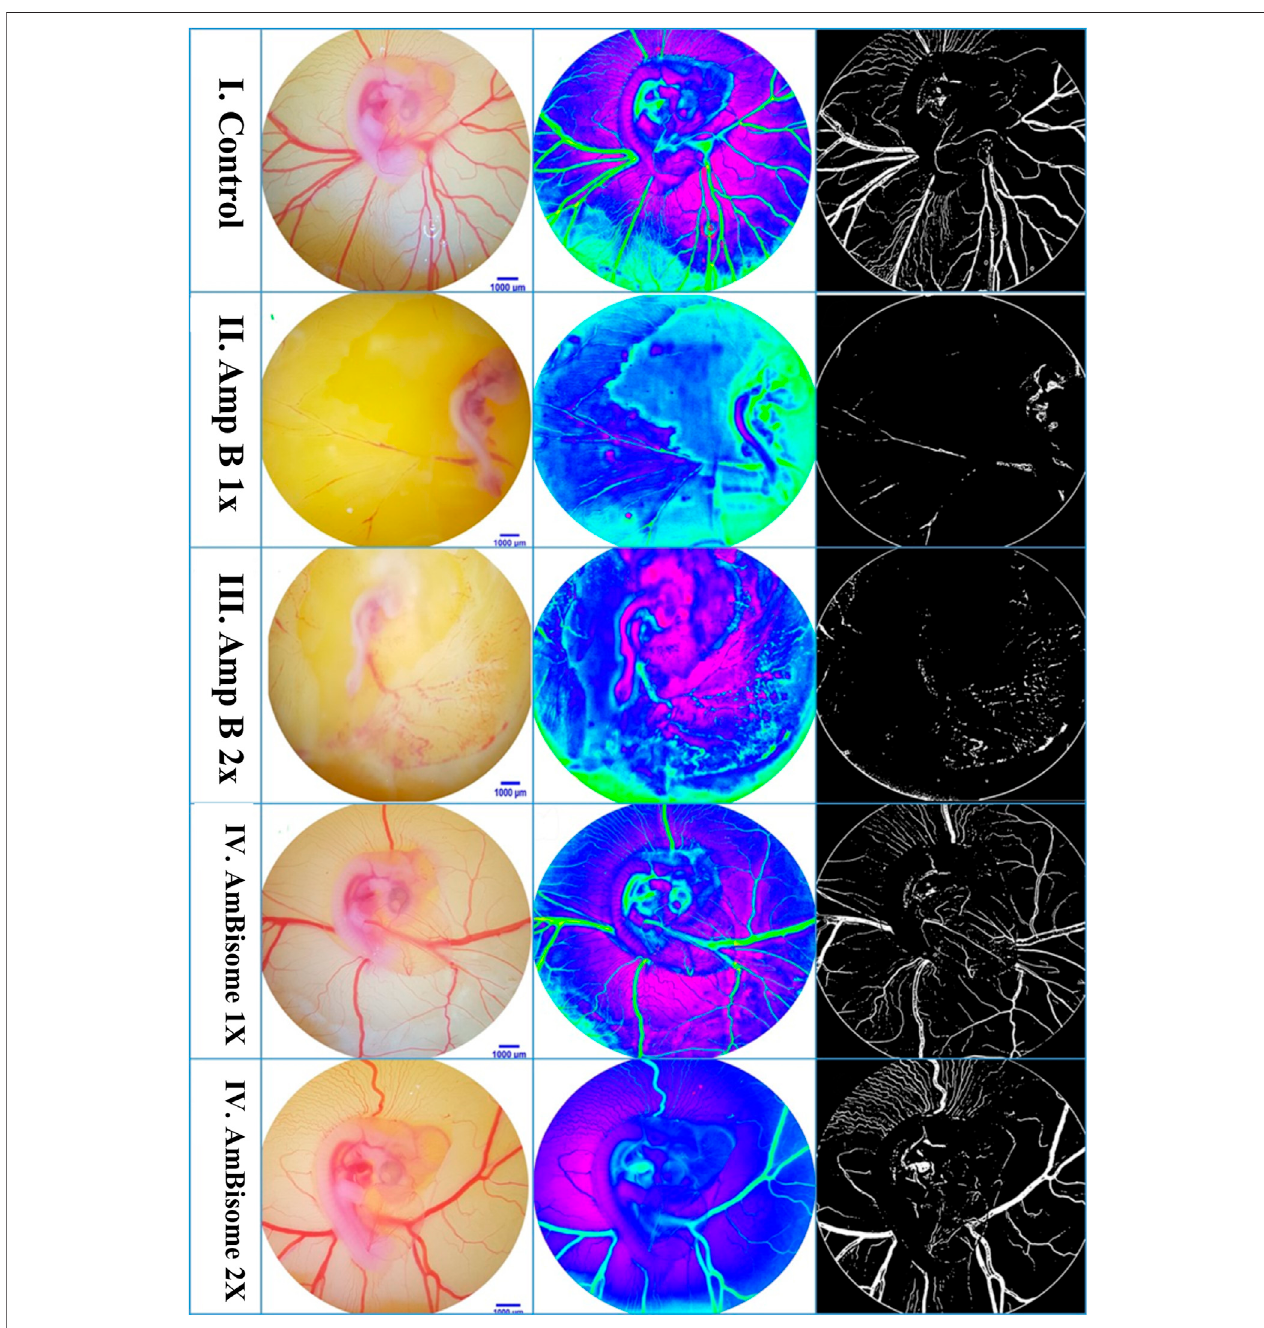
FIGURE 5 | Amphotericin B and AmBisome affect the blood vessel system. (I) Control embryo with typical blood vessel system. (II and III) Amp B 1x and 2x, respectively. The blood vessel system is disrupted. (IV and V) AmBisome 1X and 2X, respectively. A smaller decrease in vascular density was exhibited compared to Amp